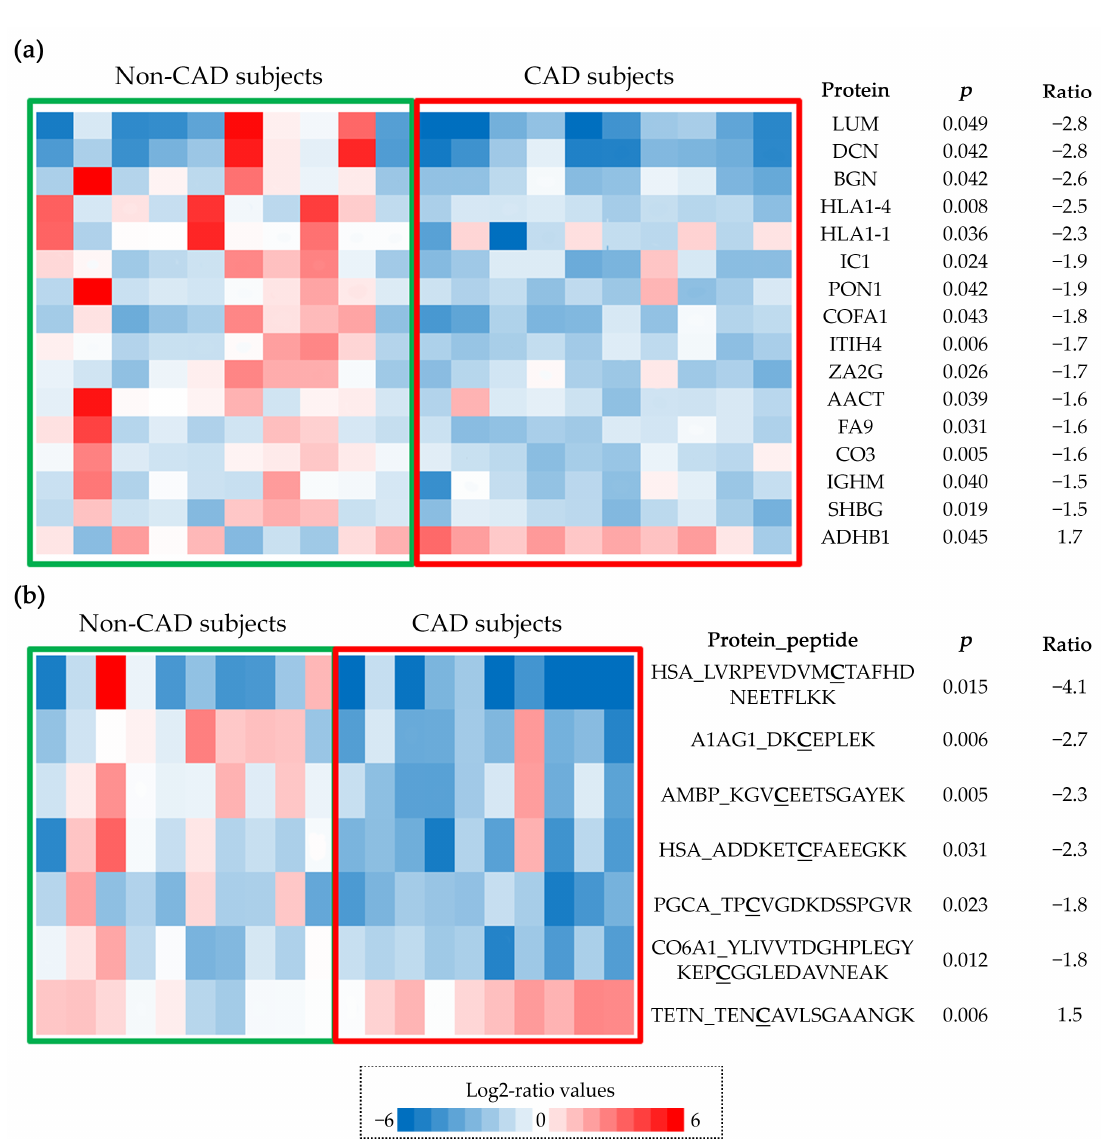
Table 3. Functional analysis of the differentially expressed proteins. The proteins are represented in clusters according to their function. The enrichment score (enrich. score), number of terms (N. of terms) and proteins included in each cluster are shown. IGHM, Ig mu chain C region;PON1, serum